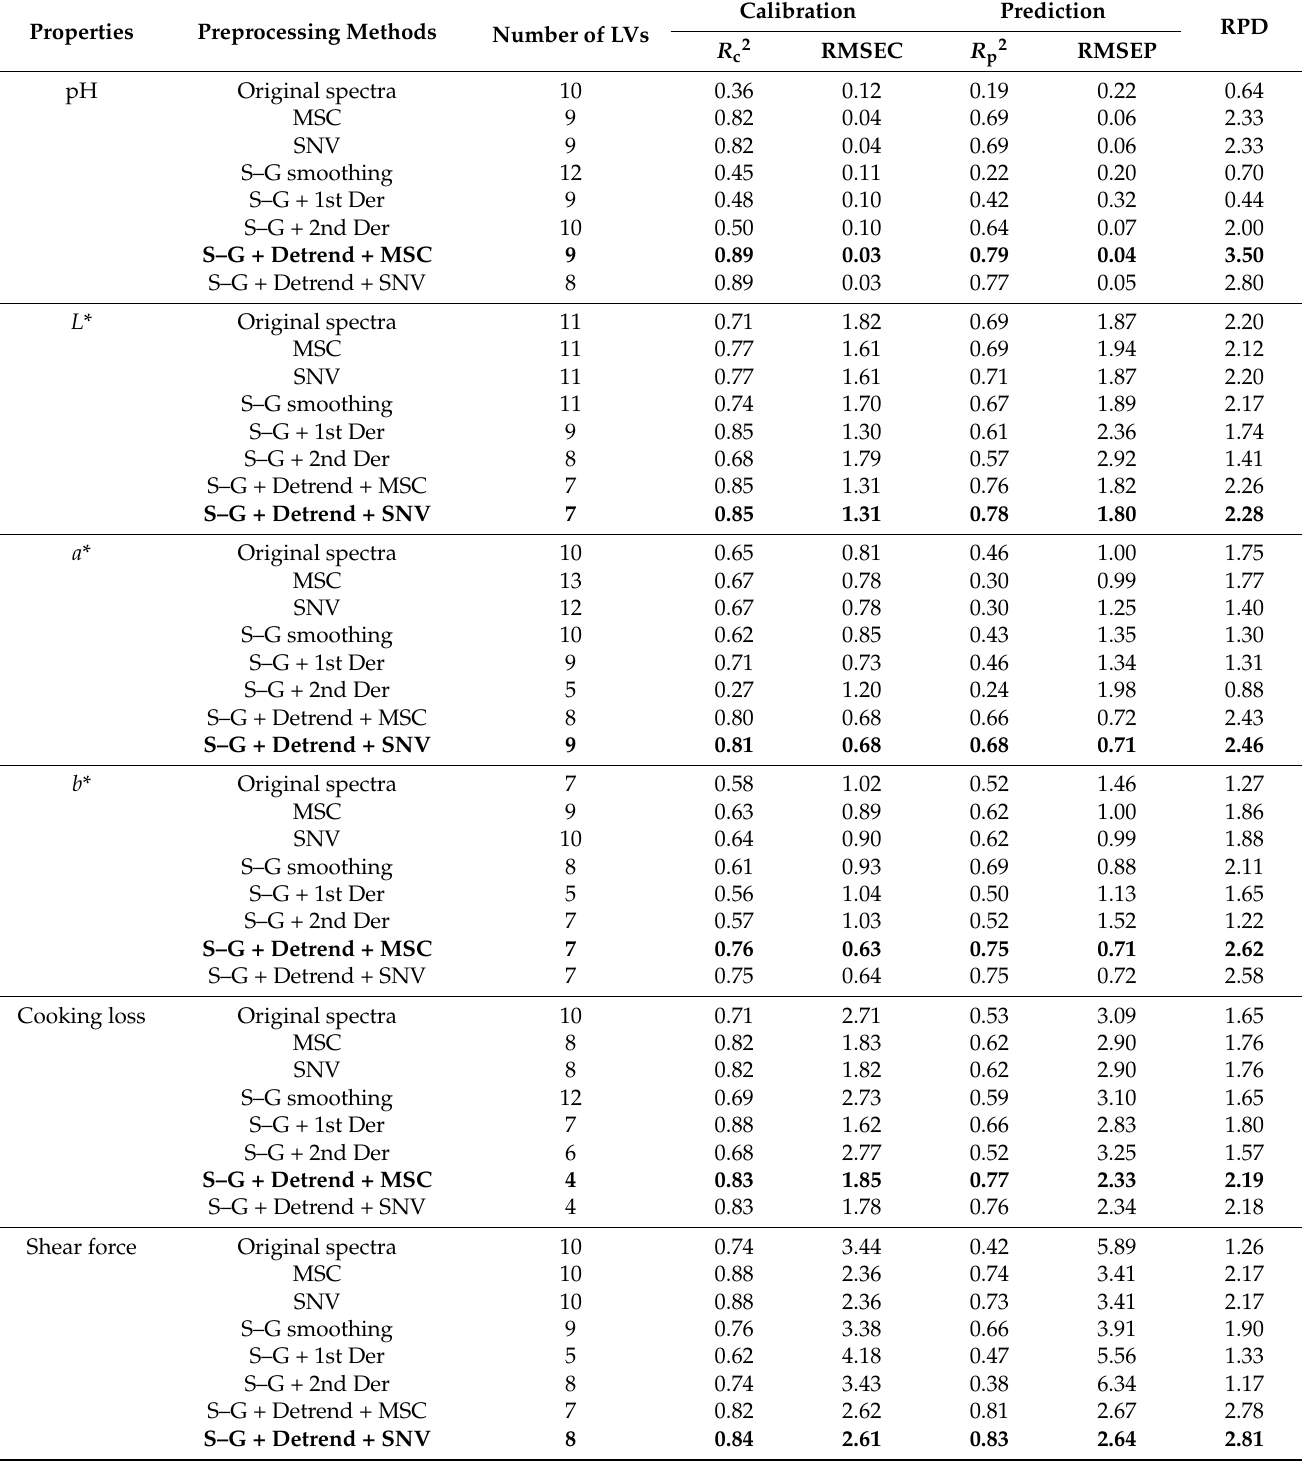
Table 4. The comparison result of PLSR models established based on the concentration gradient method for the combined meat